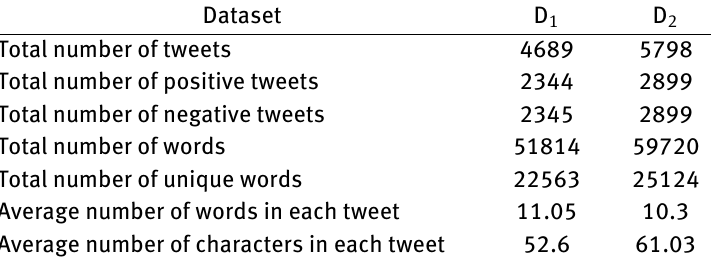
Table 5: Statistics of Arabic datasets.